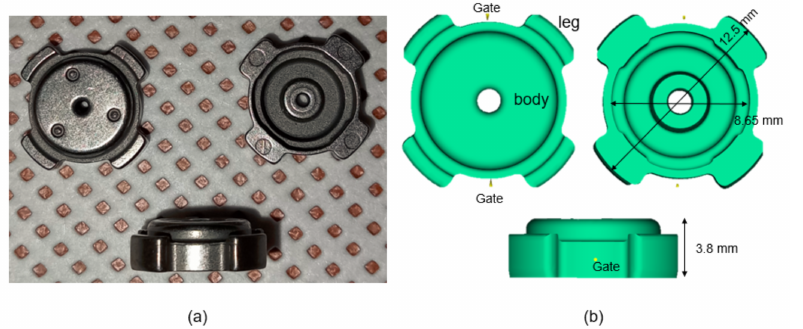
Figure 1. ( a ) Green parts and ( b ) Moldflow